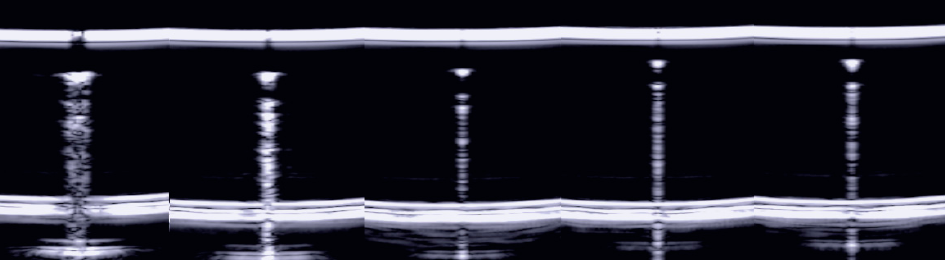
Figure 5. From right to left, the US images show how a modulated acoustic sign generated by a physical phantom becomes confused when the size of the trap input channel gradually increases.